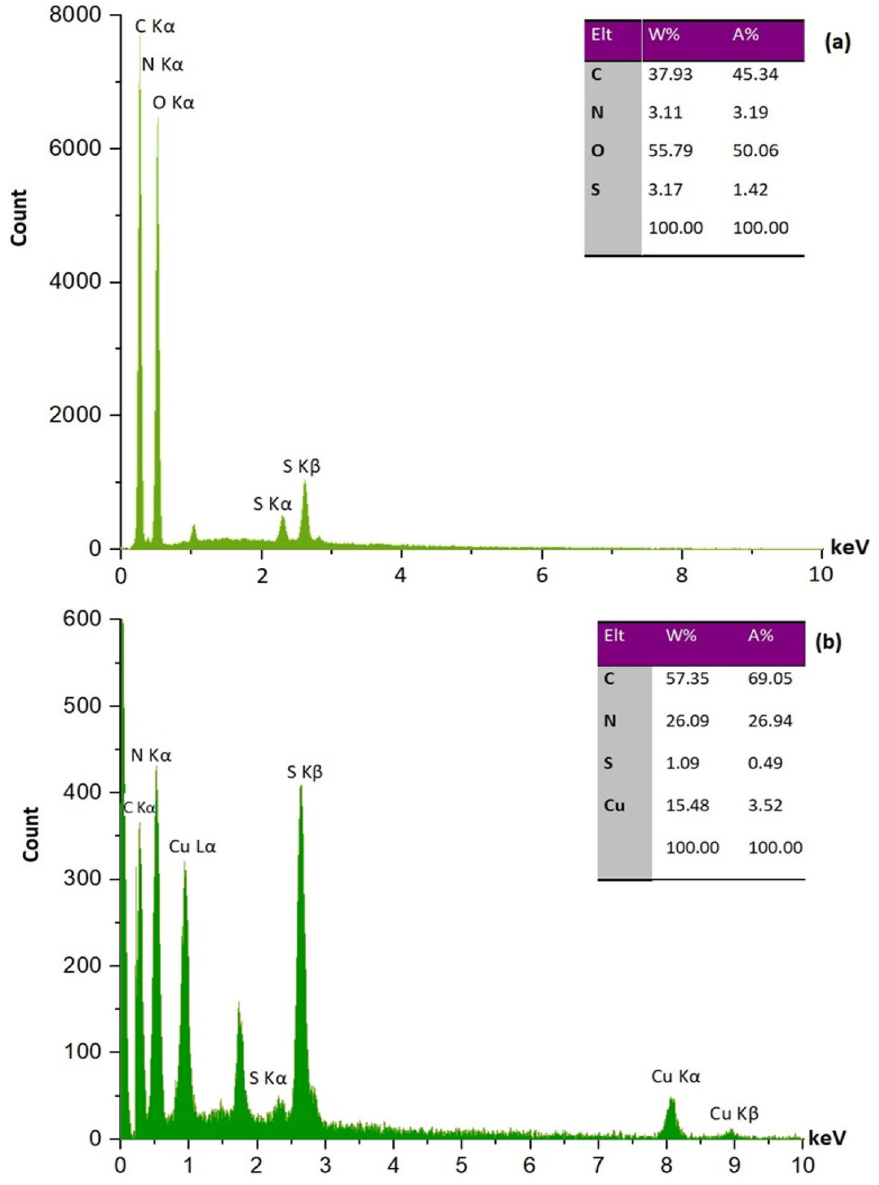
Figure 3. EDAX analysis of ( a ) β-CD-TSC and ( b ) Cu@TSC-β ‐